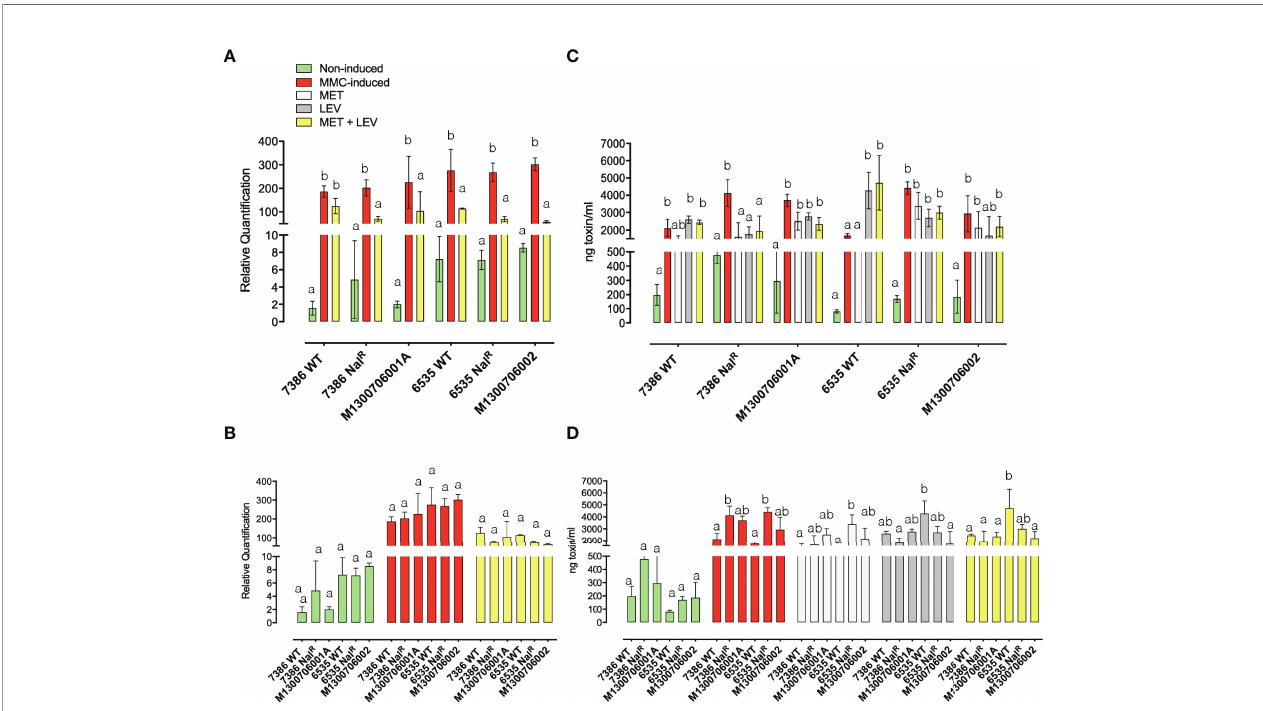
FIGURE 3 | Stx-virulence phenotypes in response to hospital administered antibiotics Stx-production of the infection-associated laboratory and clinical isolates were recorded under non-induced, MMC-induced conditions and hospital administered antibiotics. Transcripts of s tx 2a (A, B) were measured by RT-qPCR using two biological and technical replicates and normalized against the endogenous gene tufA . Values are shown in relative quantitation (RQ), after using the comparative C T ( DD C T ) method (Livak and Schmittgen, 2001). Stx 2 -production (C, D) was quanti fi ed by ELISA. Error bars depict standard deviation of two biological replicates. Statistical signi fi cance of the RT-qPCR and ELISA for each individual strain when comparing conditions (A, C) , and for each condition when comparing strains is shown (B, D) . Different letters among conditions in each strain (A, C) and among strains in each condition (B, D) indicate statistically signi fi cant